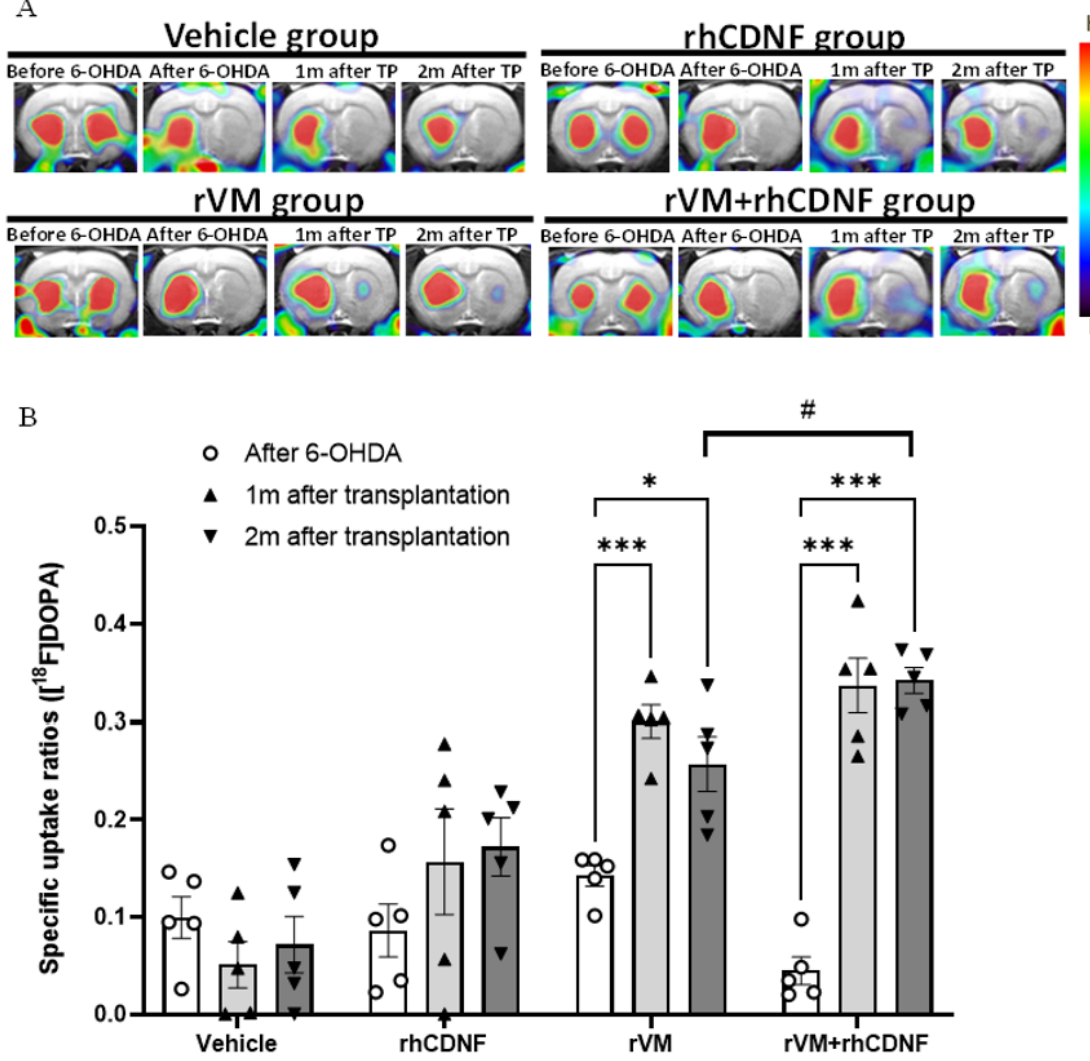
Figure 2. PET images of [ 18 F] DOPA uptake distribution in rat brains. ( A ) Coronal (upper panel) and horizontal (lower panel) sections of each group were acquired 50 − 80 min after injection of 18 F-DOPA. Left, middle, and right columns of each group represent 18 F-DOPA uptake before the 6 − OHDA lesion, after the 6 − OHDA lesion, and at 4 and 8 weeks after transplantation, respectively. ( B ) Specific uptake ratios (SURs) of 18 F − DOPA of the grafted striatum at different time points and under differ therapeutic regimen. * p < 0.05, *** p < 0.001 by Tukey’s multiple comparisons test, following two-way ANOVA. # p < 0.05 indicates comparison with the rVM + rhCDNF group with two-way ANOVA and Tukey’s post hoc test. The data represent mean ± SEM.